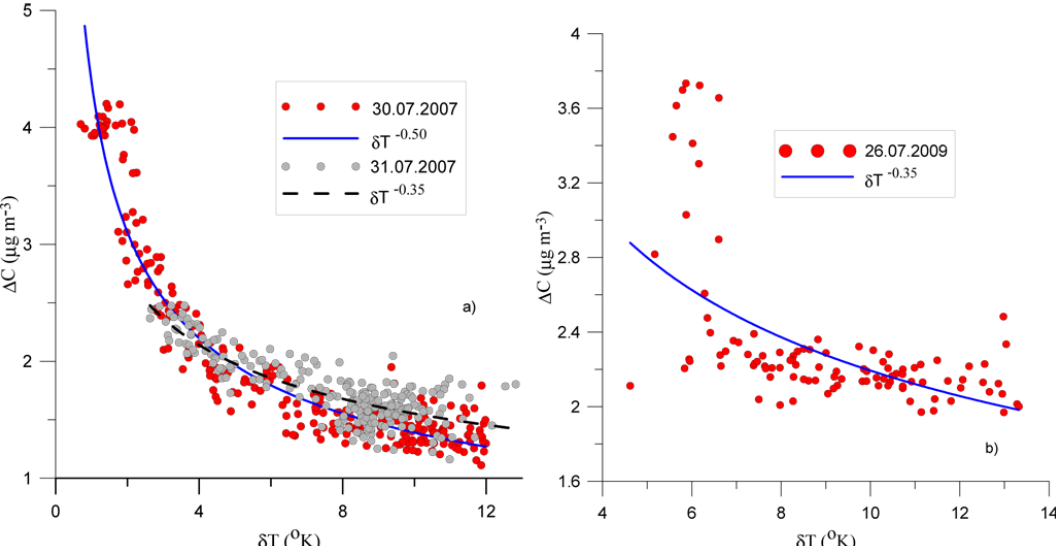
Fig. 6. Deviations of the aerosol mass concentrations obtained at a height 0.5m from the 2-m values (for 2007) and 1.5-m (for 2009) (µgm − 3 ) for particles 0.15–0.5µm in size as functions of the temperature difference δT between the ground surface and 0.2m; (a) the 2-m daytime averaged wind speed is 5.7ms − 1 for 30 July 2007, and 5.4ms − 1 for 31 July 2007, the solid line depicts the approximation 1C ∼ δT − 0 . 5 for 30 July 2007 and the dashed line corresponds 1C ∼ δT − 0 . 35 for 31 July 2007; (b) the 2.2-m wind speed is 3.0ms − 1 for 26 July p.m. 2009, the solid line depicts 1C ∼ δT − 0 . 35